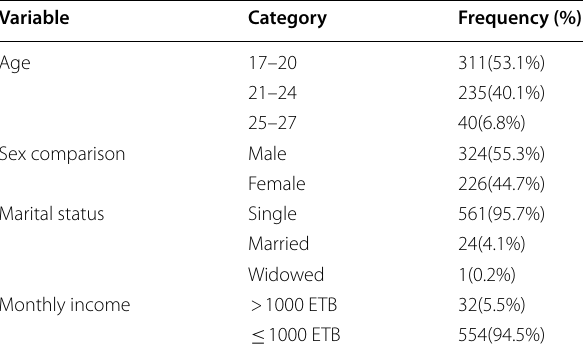
Table 1 Socio-demographic characteristics of the participants of